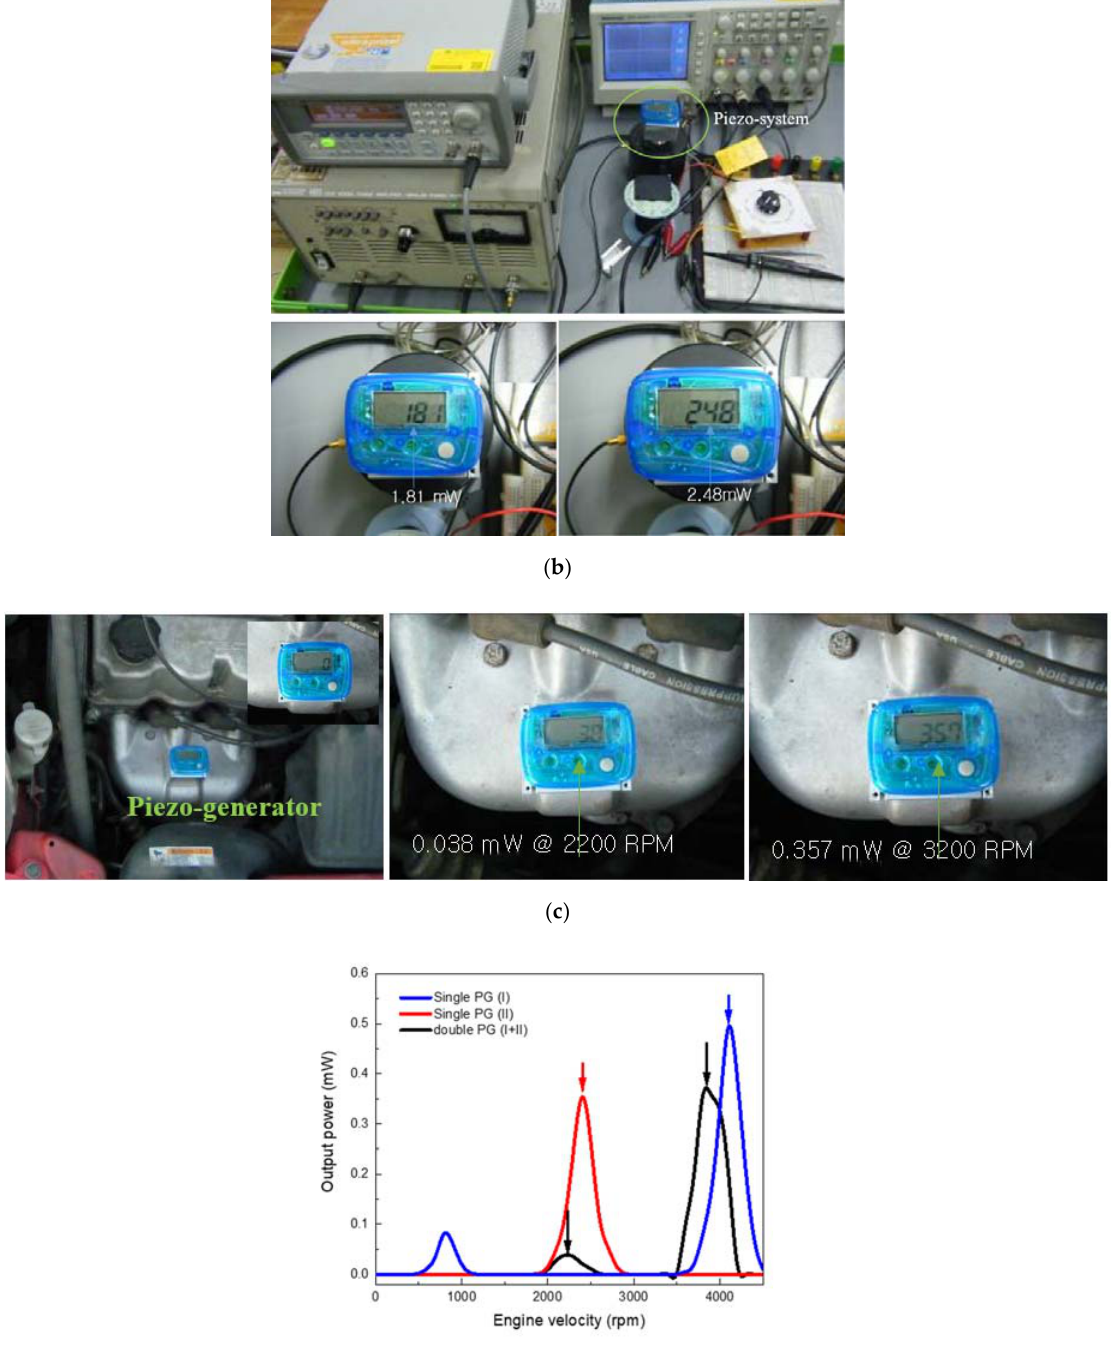
Figure 5. Fabrication and measurement of a harvesting system with double PGs (I + II). ( a ) Fabrication; ( b ) Measurement; ( c ) Installment in engine block; ( d ) Measurement of harvesting system with a single PG (I, II) and double PGs (I + II).